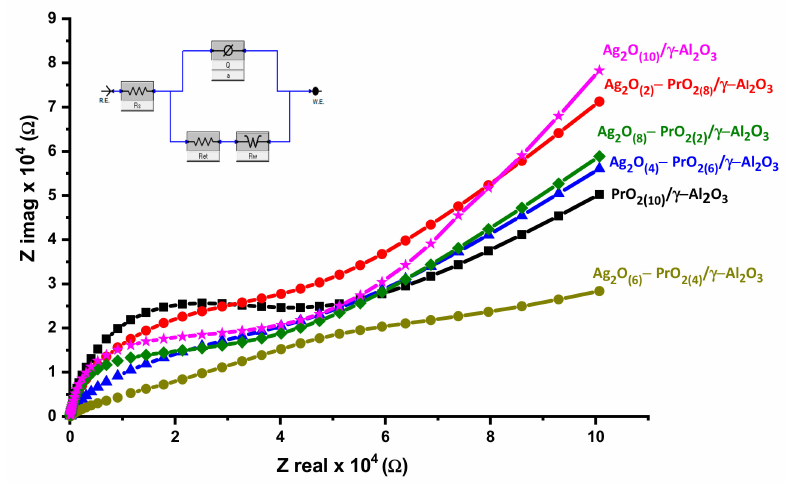
Figure 6. Nyquist plots of Ag 2 O ( x ) –PrO 2( y ) / γ -Al 2 O 3 modified electrodes recorded in 5 mM K 4 [Fe(CN) 6 ] + 3 M KCl. Inset represents the equivalent circuit. Table 3. Parameters corresponding to electrochemical impedance (EIS) response of